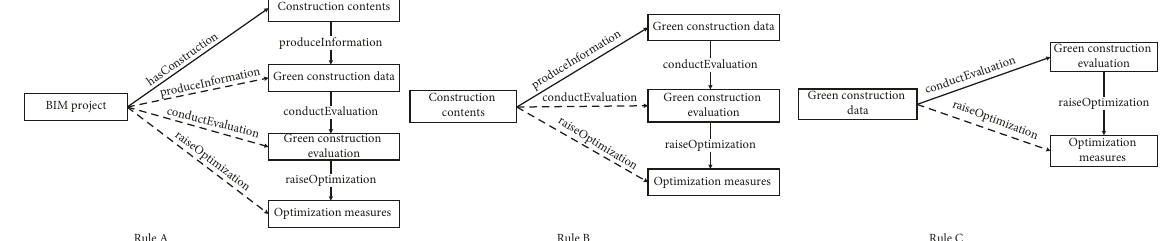
Figure 10: Illustration of SWRL rules.